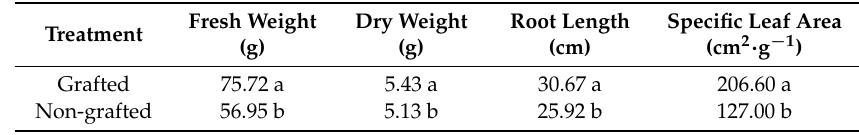
Table 3. Effect of grafting on watermelon biomass production.